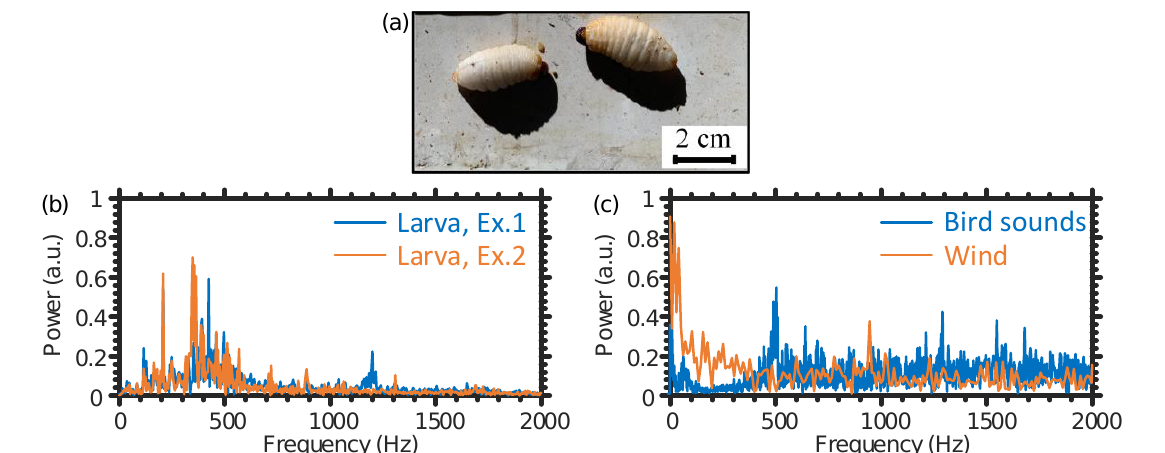
Figure 4. ( a ) ∼ 12 days old weevil larvae. ( b ) Two representative examples of the larvae sound’s spectra, marked as Ex. 1 and Ex. 2, produced using the data of the voice recorder. ( c ) Examples of the power spectra produced by bird sounds and